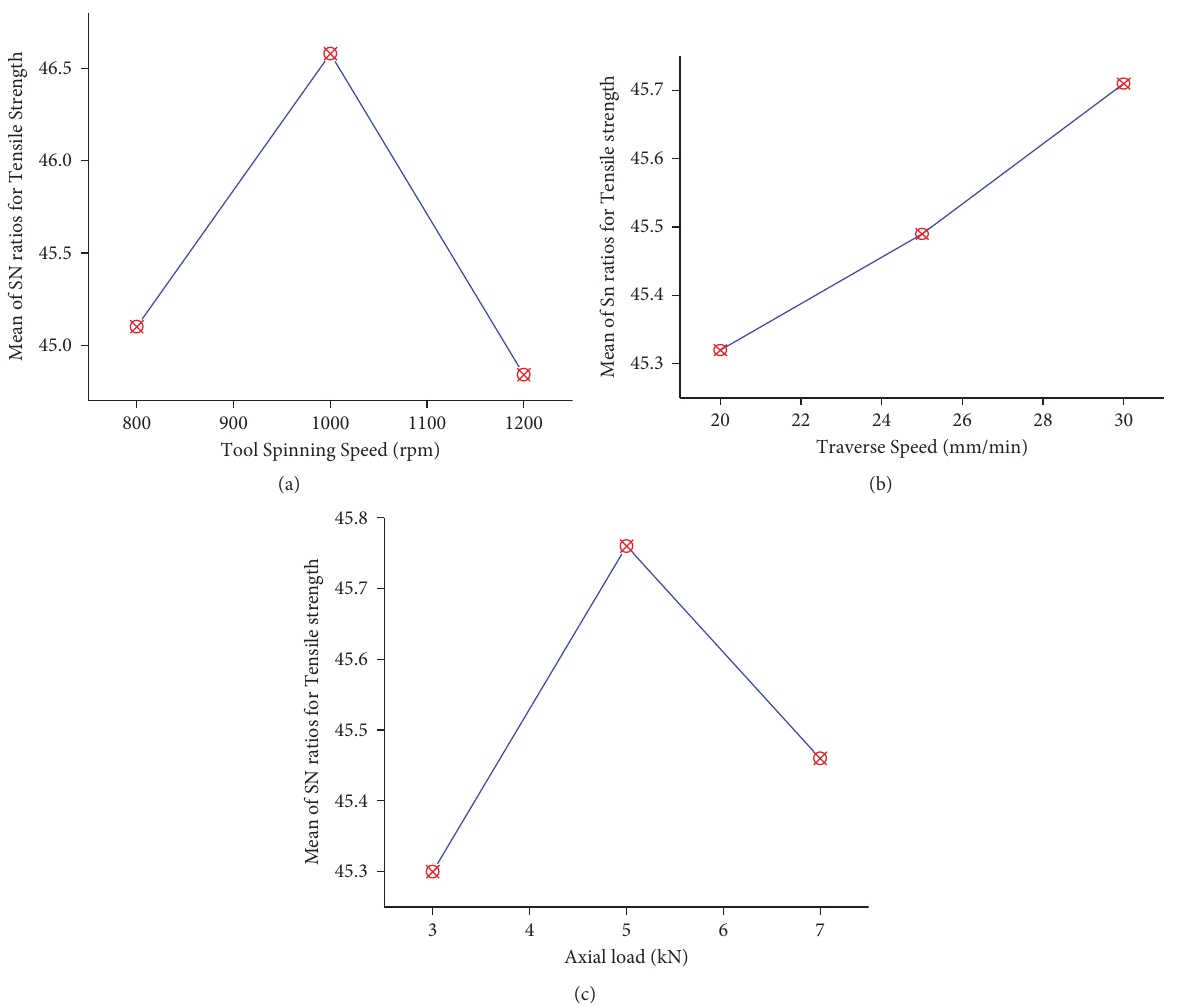
Figure 3: Mean of S/N ratios for (a) tensile strength versus tool spinning speed, (b) tensile strength versus traverse speed, and (c) tensile strength versus axial